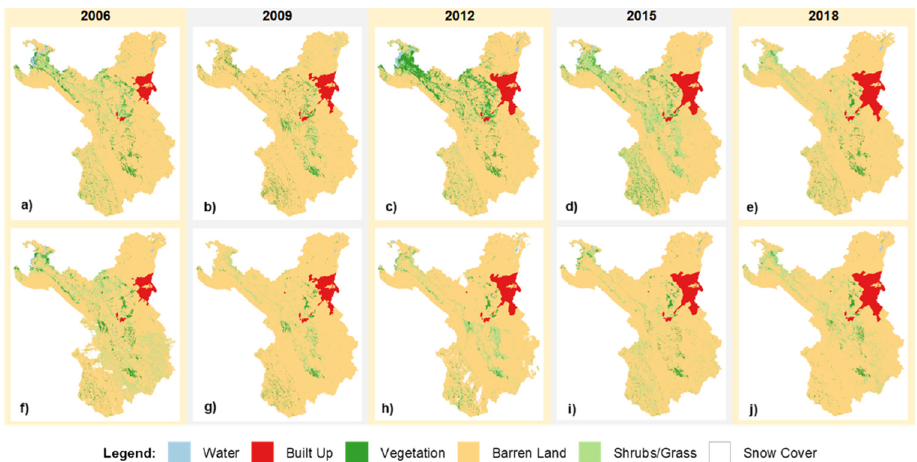
Figure 2. Land cover maps with a three-year time step. Images corresponding to dry season ( a – e ) and wet season ( f – j ). Unclassified patches correspond to masked clouds. Table 2. Land cover classes in area (km 2 ) and % obtained from LC classification for dry season.